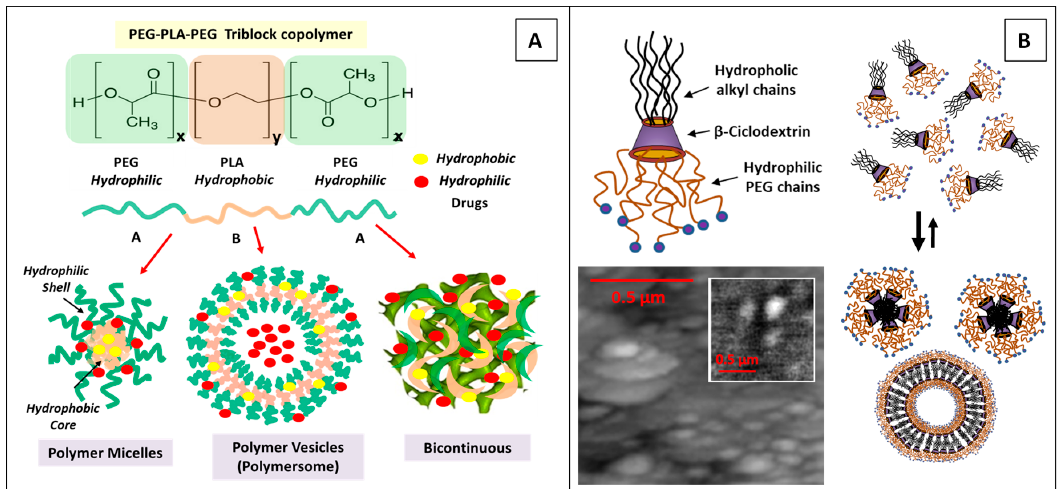
Figure 9. Structural features of the amphiphilic poly(ethylene glycol)-polylactide-poly(ethylene glycol) (PEG-PLA-PEG) triblock copolymers and its use as drug delivery nanocarrier (in the form of micelles, vesicles and bicontinuous phase) for both hydrophobic and hydrophilic drugs ( A ). Self-assembly process of cationic SC6CDNH2 modified cyclodextrins ( B ), and the relative SNOM optical images (inset) of the aggregates obtained by the self-assembly process between anionic TPPS porphyrins and cationic modified amphiphilic cyclodextrins (at 1:10 porphyrin/CD molar ratio). Linear Pluronic-type ABA amphiphilic triblock copolymers of poly(ethyleneoxide)-poly(propyleneoxide)-poly(ethyleneoxide) (PEOm-PPOn-PEOm), also known